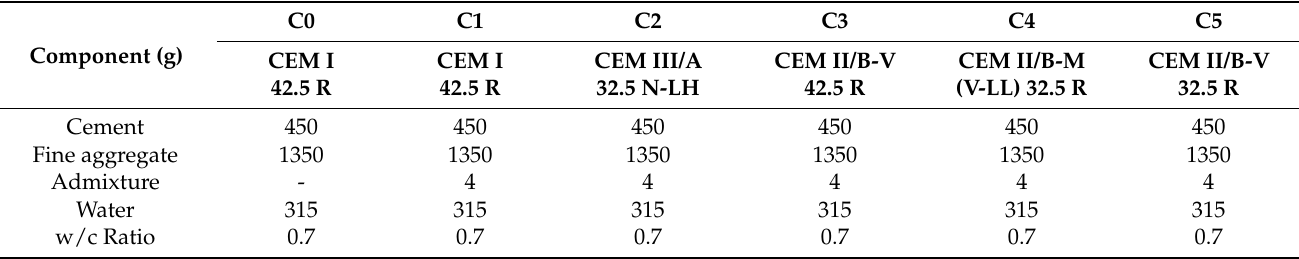
Table 3. Mortar mix proportion of all